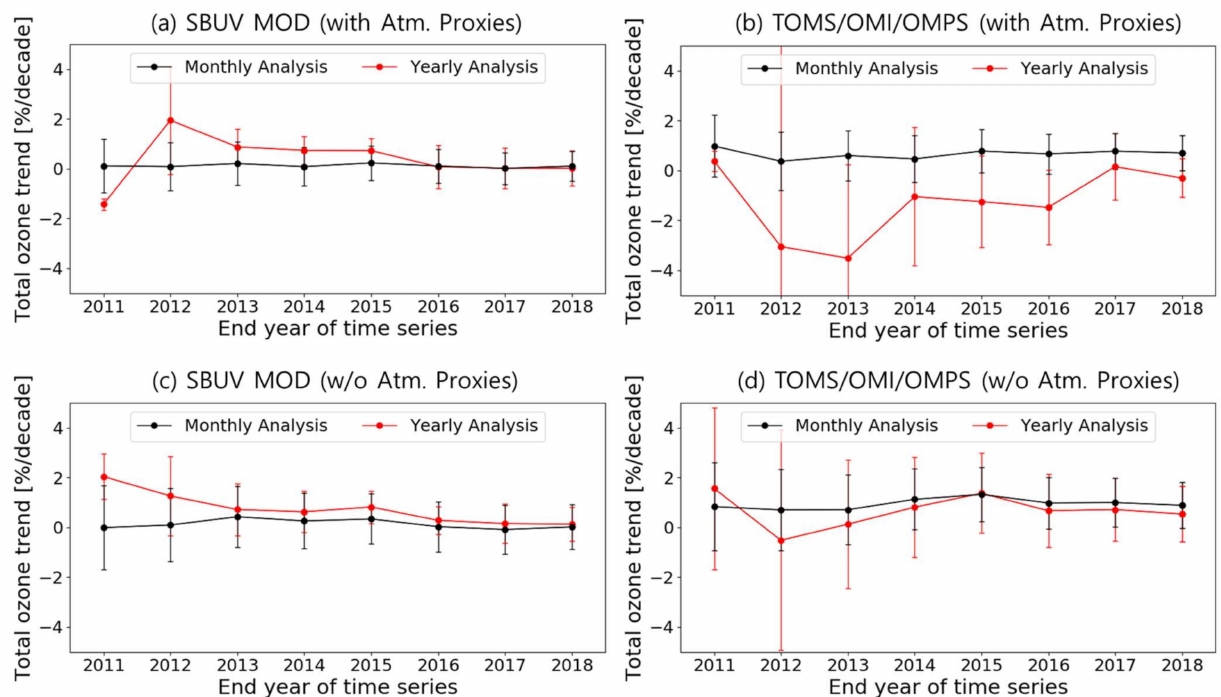
Figure 6. Dependence of analysis periods for the SBUV zonal averaged between 35–40 ◦ N ( a , c ) and TOMS/OMI/OMPS data over Pohang ( b , d ) in the MLR analysis. The start year for all analysis is fixed to 1997 and the x -axis means the end year of the analysis periods. The upper panels ( a , b ) use atmospheric proxies and the bottom panels ( c , d ) do not use atmospheric proxies. The red and black lines are the results from the yearly and monthly MLR fits, respectively. The vertical bars show the 2-sigma uncertainties in the